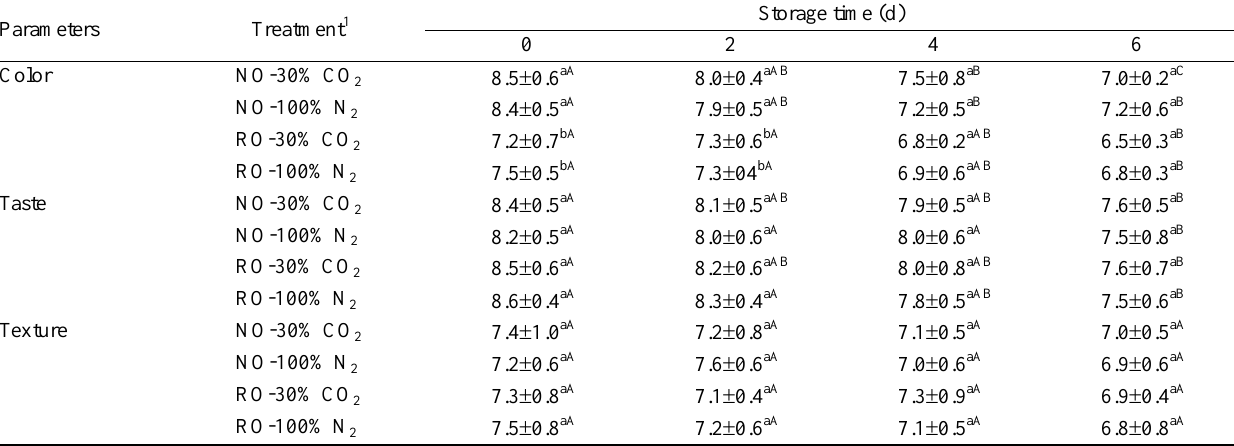
Table 3. The effect of modified atmosphere packaging (MAP) and additive mixture on the sensory evaluation of pre-cooked hamburger patties during refrigerated storage Parameters